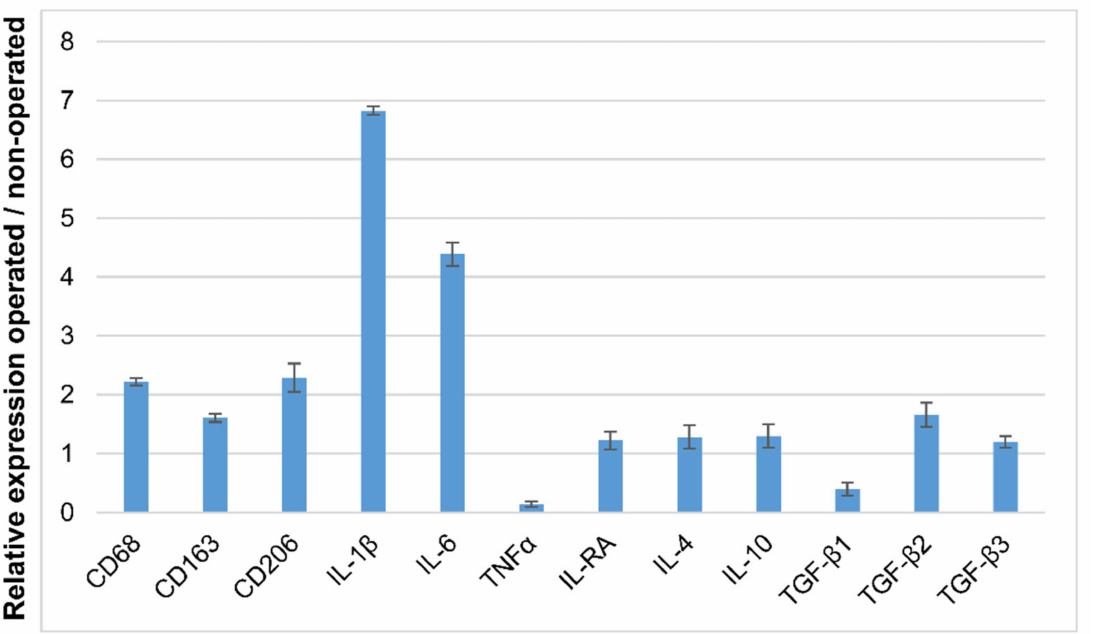
Figure 8. Expression of the different marker genes and cytokines in the operated femur; qRT-PCR analysis of the different gene expressions. This result is the average of three